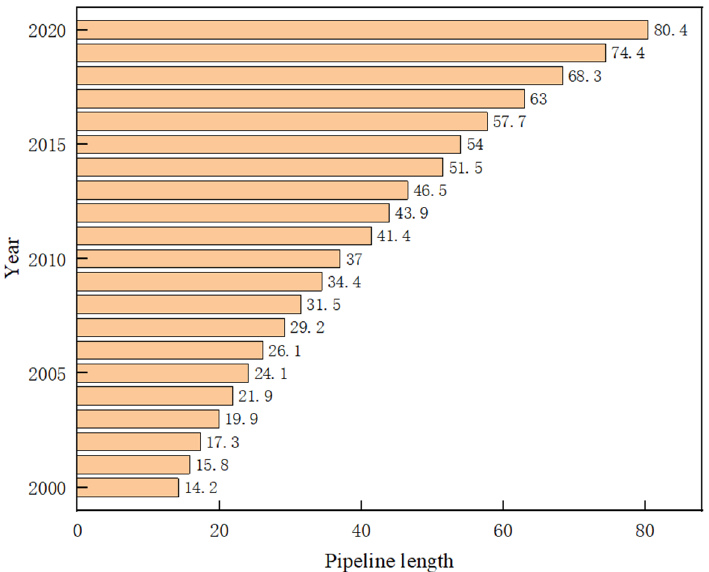
Figure 1. Urban drainage pipeline length [1].